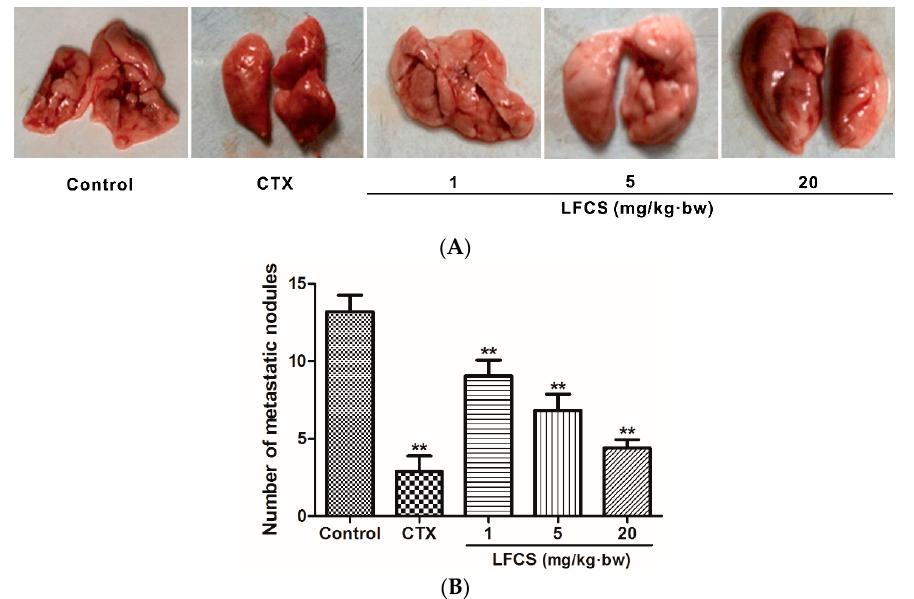
Figure 2. LFCS suppressed lung metastasis of LLC cells in vivo . ( A ) Representative photos of lungs with the metastatic colonies after treatment with LFCS or not. Tumor-bearing mice were euthanized, and the lungs excised and counted the metastatic nodules ( B ) Lung metastatic nodules. Data are represented as mean ± SD ( n = 8). ** p < 0.01, significant difference compared with control group (NS group).